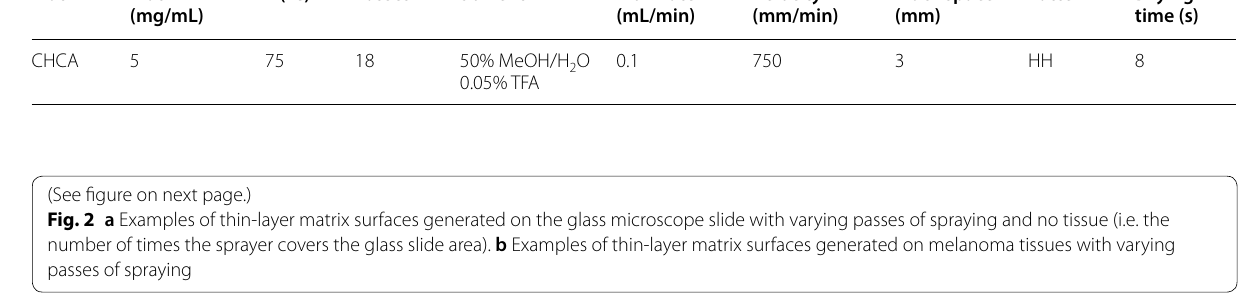
Table 1 Tissue preparation parameters optimised for melanoma tissues surgically isolated from lymph nodes